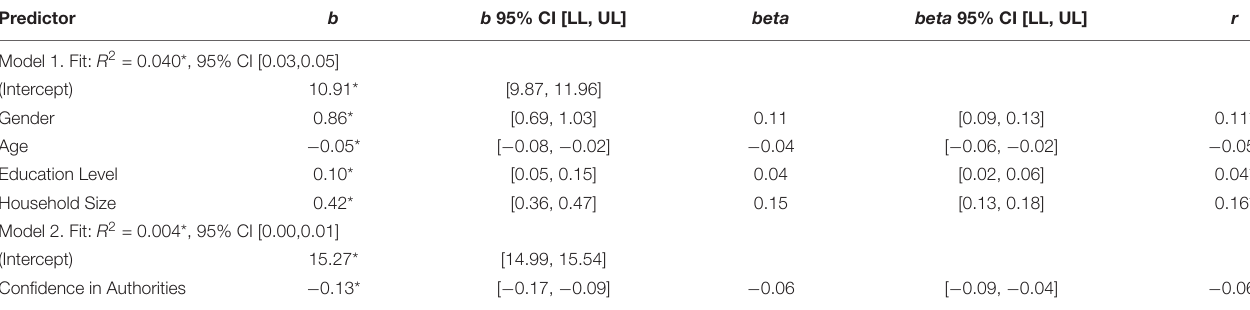
TABLE 1 | Regression models results using health-protective behavior as the criterion. Predictor